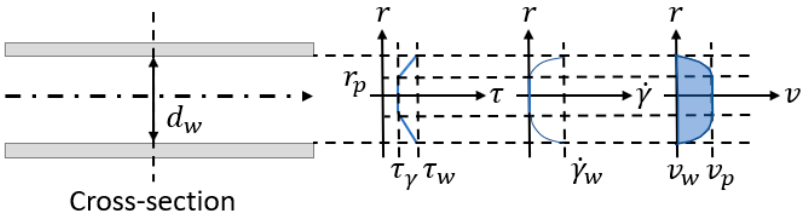
Figure 2. Schematic view of the shear stress, shear rate and velocity profiles in a cross-section.